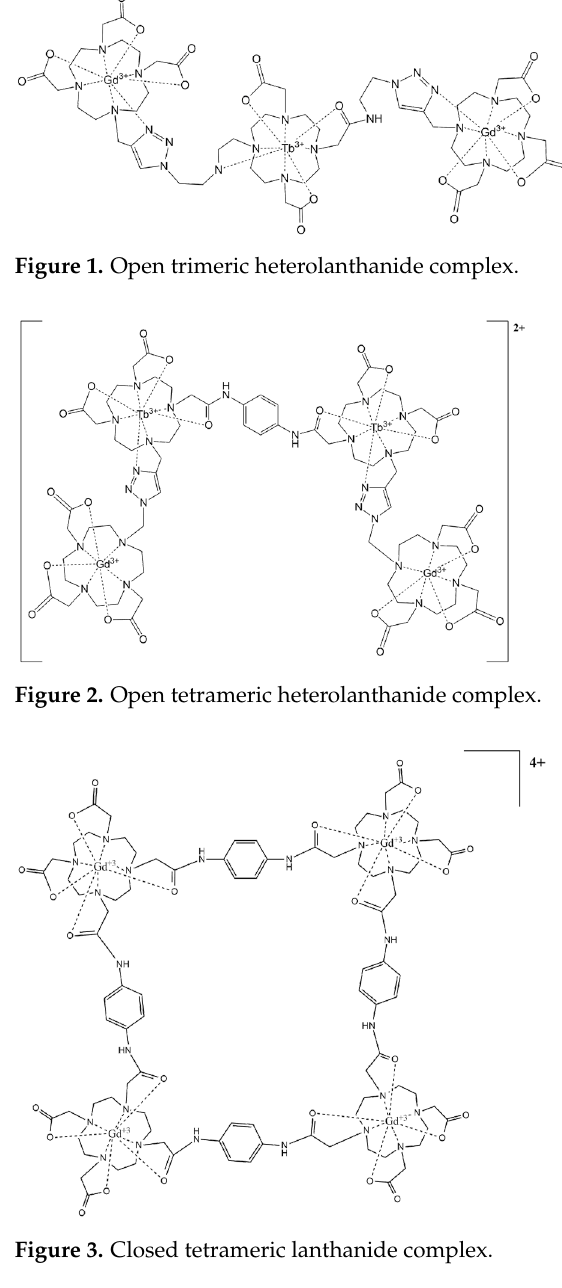
Figure 4. Synthetic pathway for molecules 1–13 and 17.